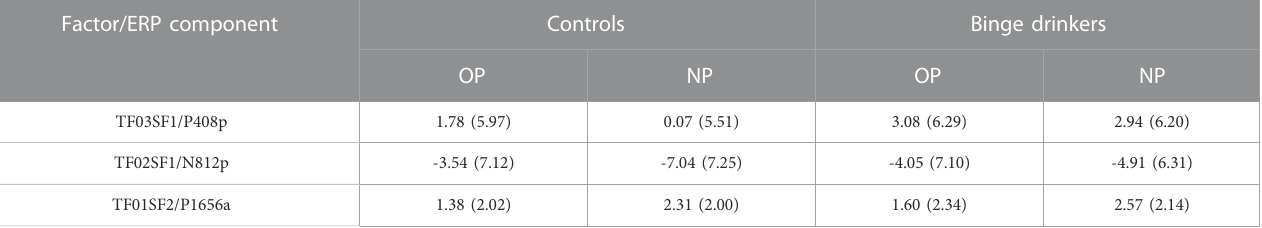
TABLE 5 Mean (standard deviation) amplitude of the selected ERP components (factors rescaled to µV at the peak latency and electrode site) for each group (binge drinkers and controls) and type of stimulus (old and new word pairs, OP/NP) (ordered by latency). Factor/ERP component